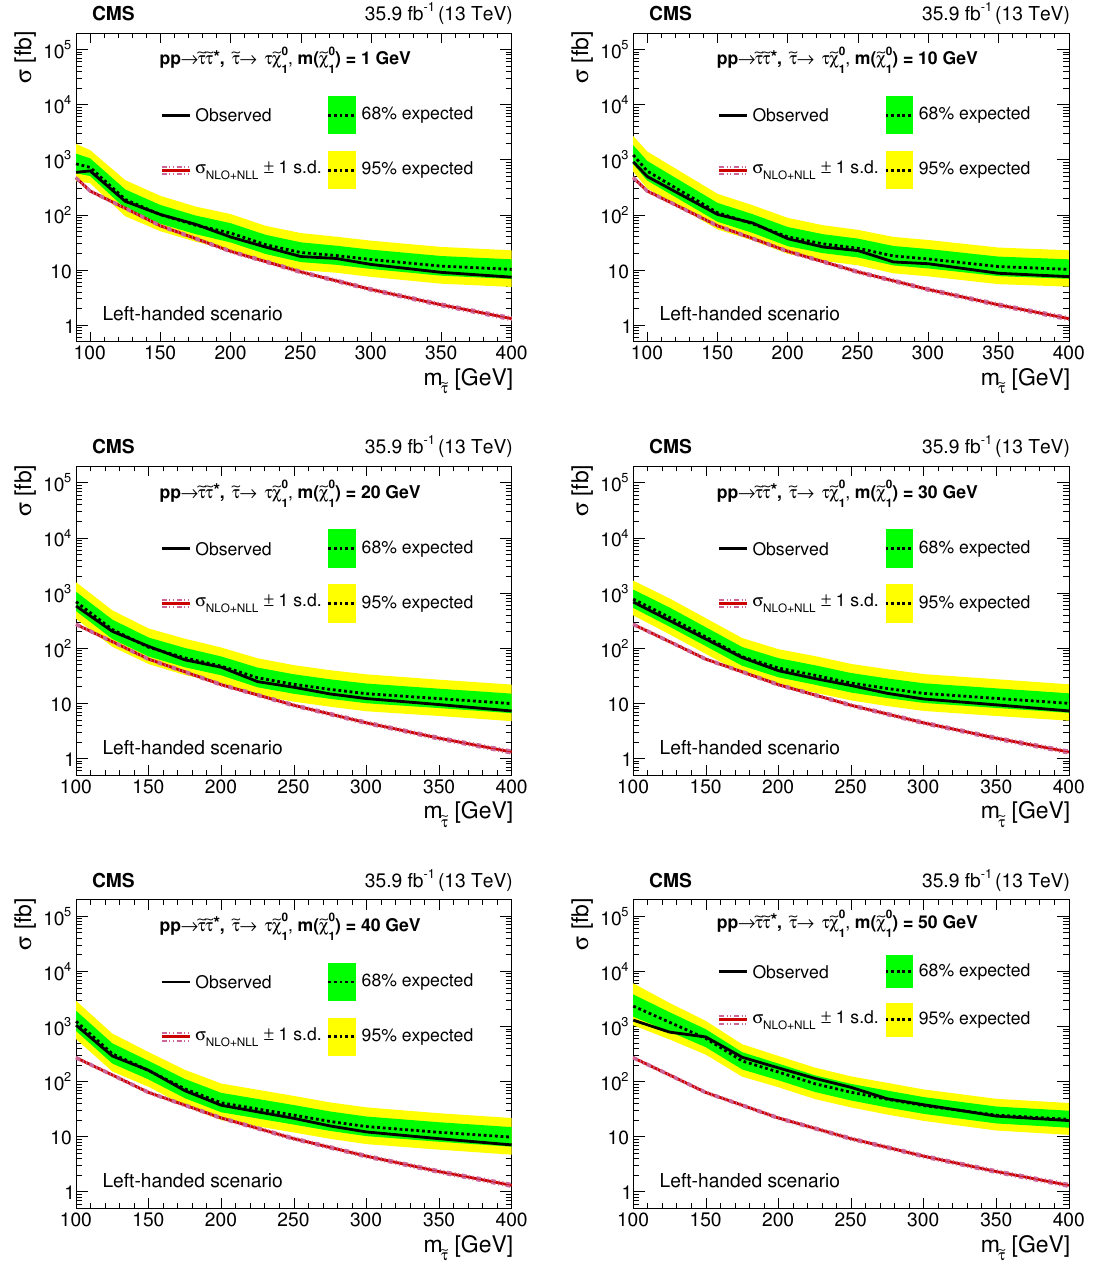
Figure 11. Excluded (cid:28) pair production cross section as a function of the (cid:28) scenario, and for di(cid:11)erent (cid:31) 0 masses of 1, 10, 20, 30, 40, and 50 GeV from upper left to lower right, 1 respectively. The inner (green) band and the outer (yellow) band indicate the regions containing 68 e and 95%, respectively, of the distribution of limits expected under the background-only hypothesis. e e The red line indicates the NLO+NLL prediction for the signal production cross section calculated with Resummino [47], while the red hatched band represents the uncertainty in the prediction.